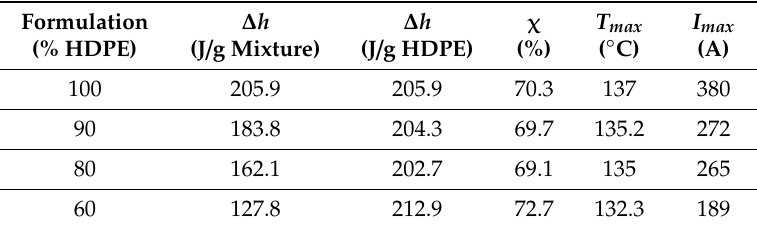
Table 3. Thermal test results.